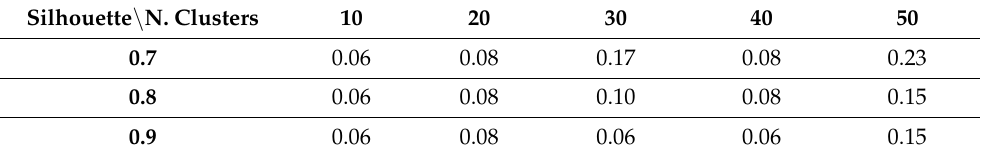
Table 4. Clustering performance in terms of silhouettes using normalized data. Silhouette \ N. Clusters